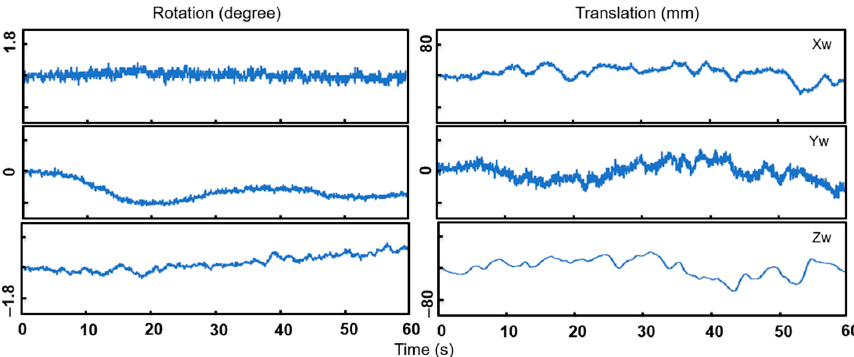
Figure 15. Six degrees of freedom motion of the UAV ( Z w = 1000).